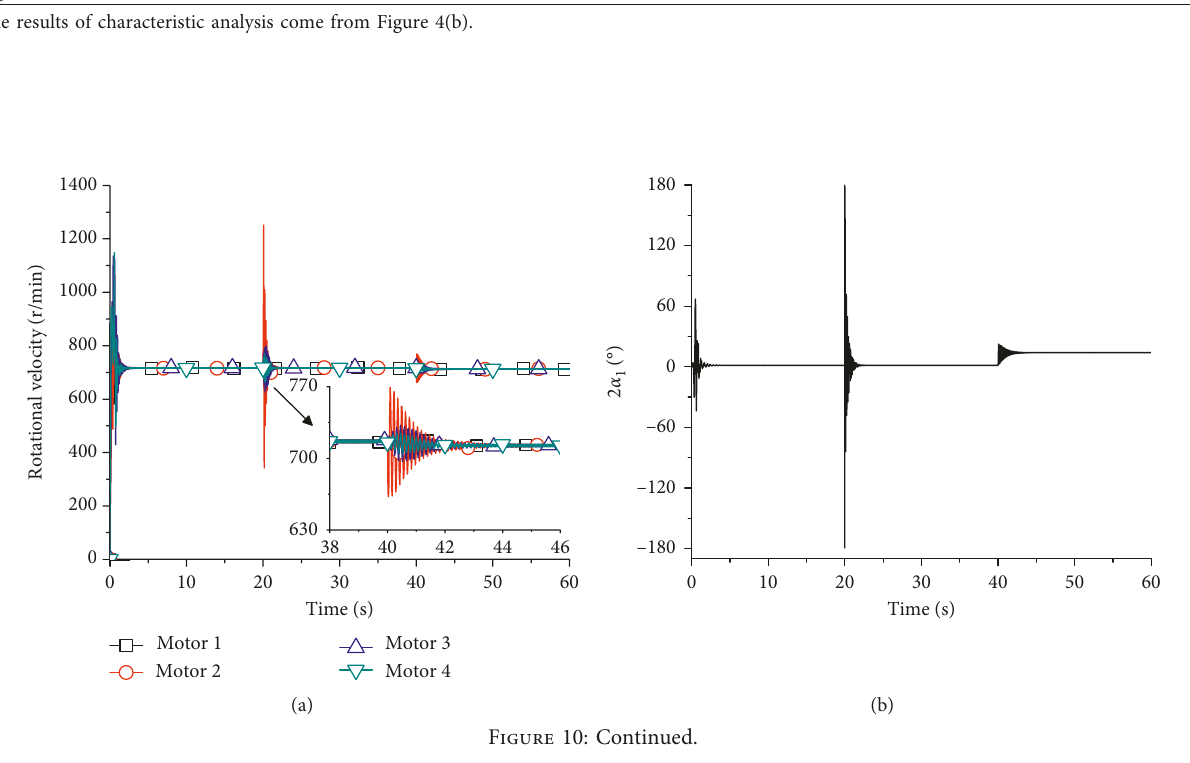
Figure 9: Results of computer simulations for η between vibrators 1 and 2; (c) phase difference between vibrators 2 and 3; (d) phase difference between vibrators 3 and 4.